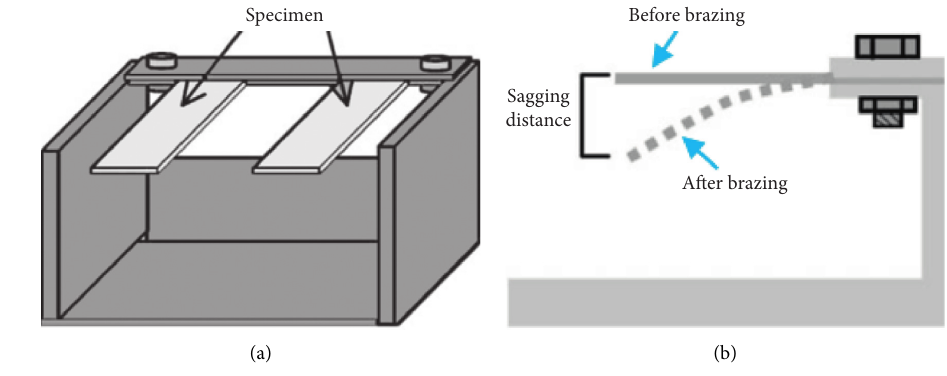
Figure 4: Schematic illustration of sagging